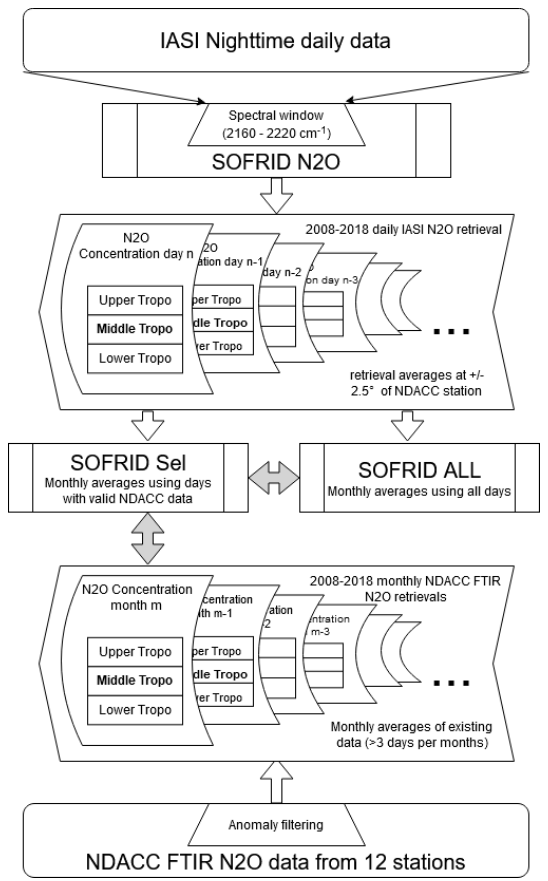
Figure 4. Flow chart of the validation methodology.